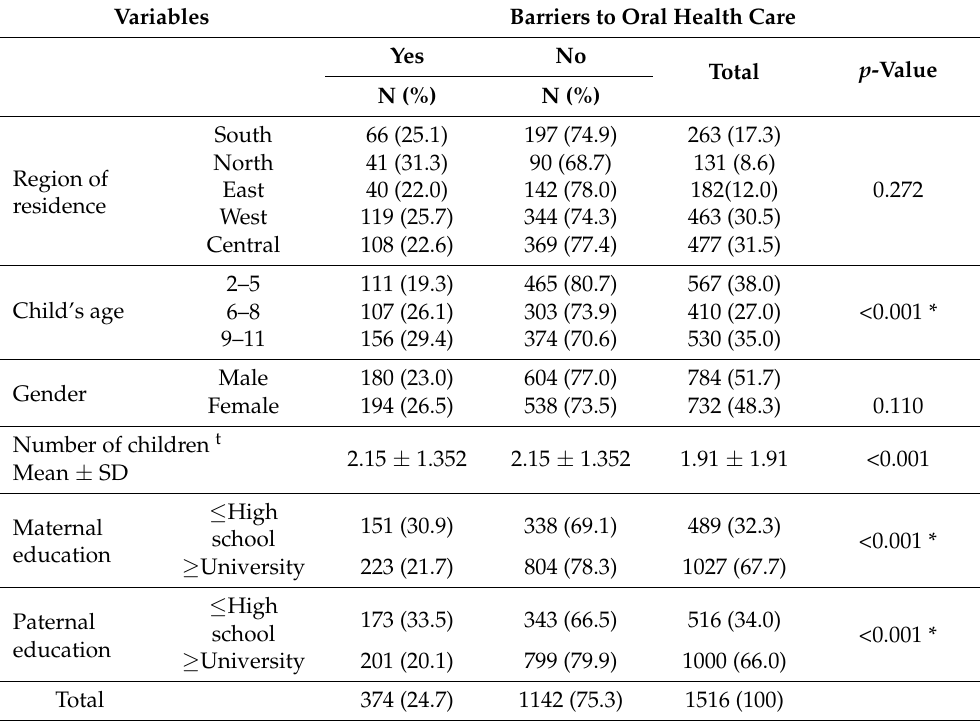
Table 1. Participant characteristics distributed according to a parental report of their children’s barriers to oral health care (N =